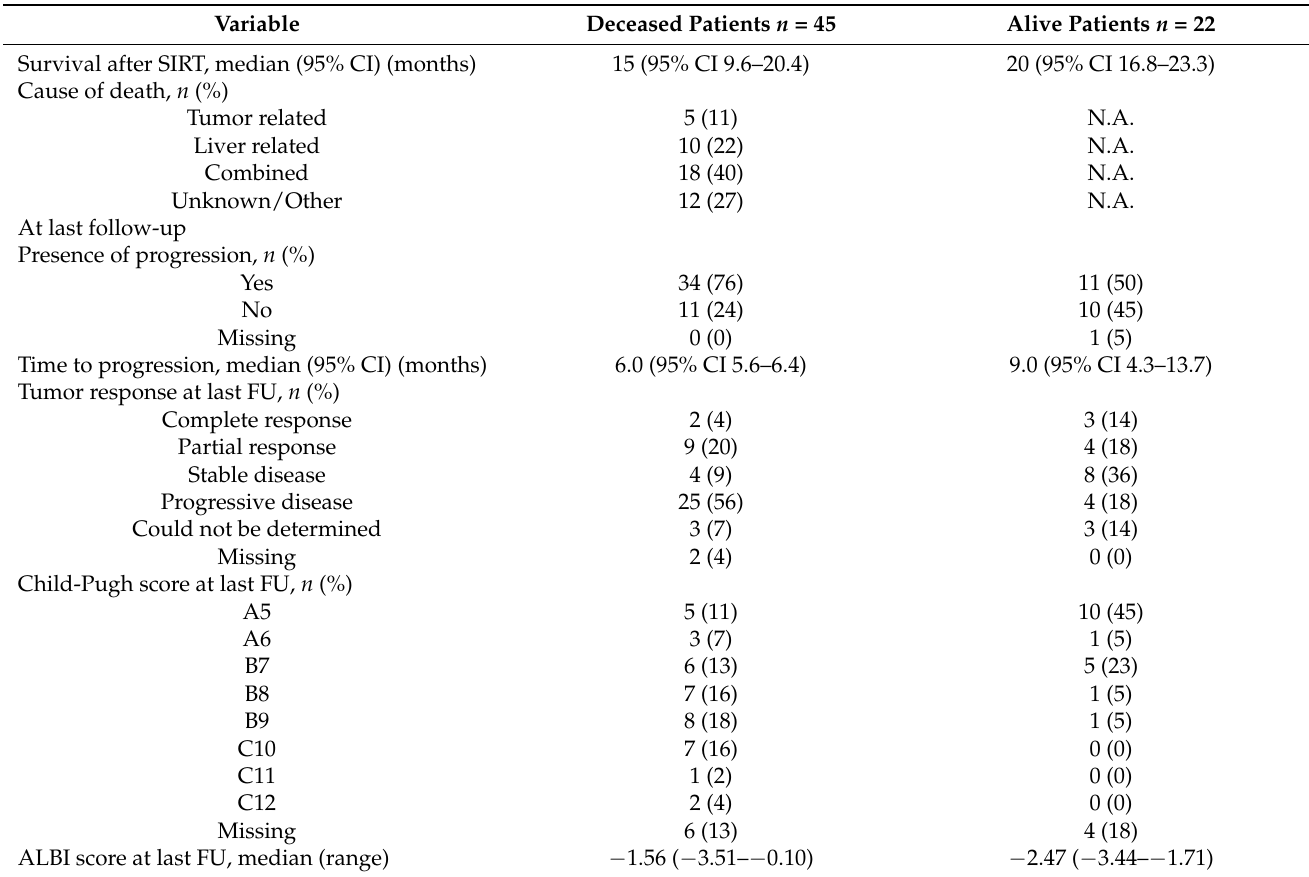
Table 2. Outcome summary of patients treated with